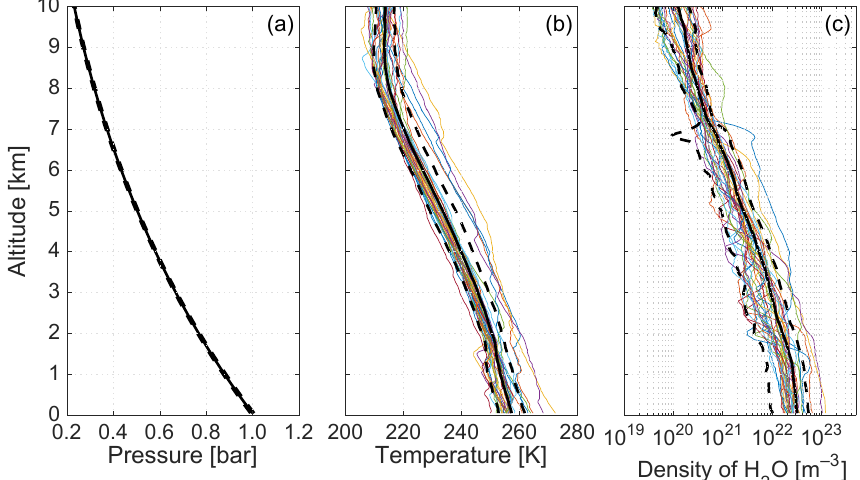
Figure 1. Atmospheric profiles used in the water vapour absorption model, measured by radiosonde over Ny-Ålesund, Svalbard, from Maturilli and Kayser (2016). Panel (a) shows the pressure as a function of altitude, panel (b) shows the temperature, and panel (c) shows the number density of H 2 O. The coloured lines each represent a daily observation during the month of December 2003; the mean profiles from this month are plotted in solid black lines with 1 standard deviation from the mean shown in dashed black